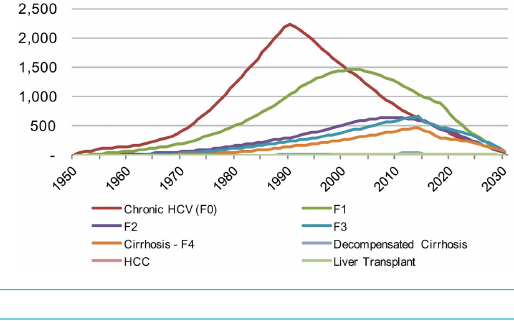
Figure 10: Distribution of viremic infections by disease stage in the canton of S. Gallen, from 1950–2030 under the Base 2016 scenario.